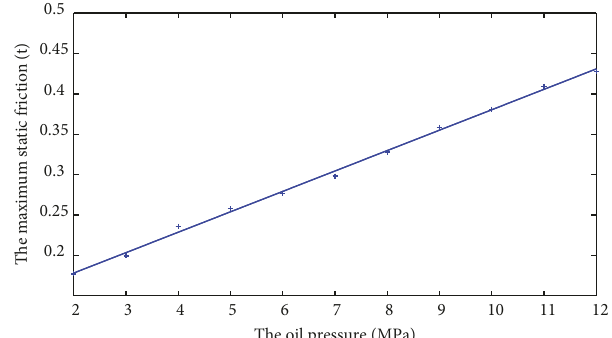
Figure 16: Effect of pressure change on the maximum static friction force.